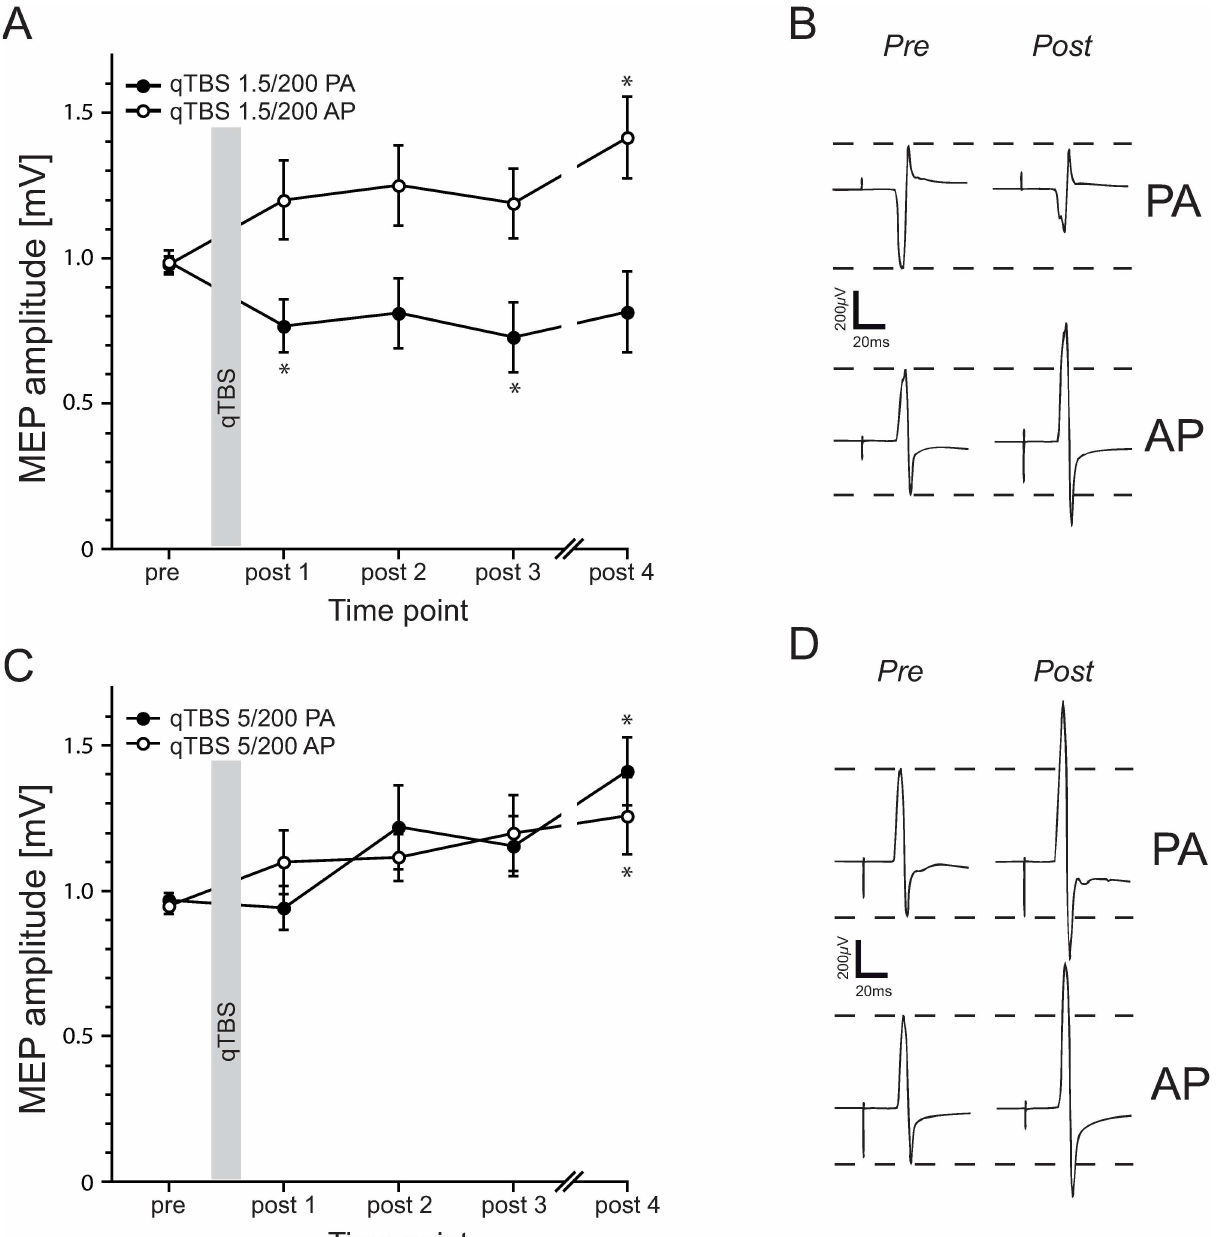
Fig 3. Results of MEP data after qTBS. (A) Timecourseof MEP amplitudes after qTBS at ISI of 1.5 ms in AP and PA direction. Flipping the current flow in M1-HAND led to bi-directional changesin synapticplasticity with a significantincrease of cortico-spinal excitabilityin AP direction and a significantdecreasein PA direction. (B) MEP amplitudesof one representative subject before and after (POST4) qTBS 1.5 ms in AP and PA direction. Shownare averagesof 20 MEP trials in each case. (C) Timecourseof MEP amplitudesafter qTBS at ISI of 5 ms in AP and PA direction. In both current directions (i.e. AP and PA), MEP amplitudes significantly increasedafter qTBS. (D) MEP amplitudes of one representative subject before and after (POST4) qTBS at ISI of 5 ms in AP and PA direction. Shownare mean amplitudes of averages of 20 MEP trials in each case. Asterisks indicate significantdifferences betweenpre and post measurements ( p < 0.05,paired t -test). Error bars indicate the standarderror of the mean (S.E.M.). qTBS: quadri-pulse theta burst stimulation;PA: posterior-anterior; AP: anterior- posterior; ISI: interstimulus interval; MEP: motor evoked